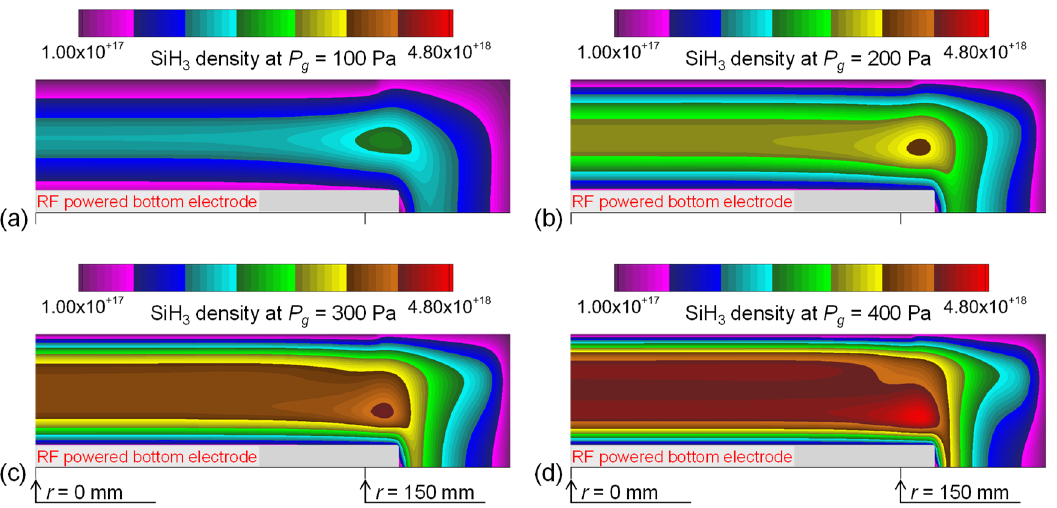
Figure 9. The spatial profiles of the time ‐ averaged SiH 3 density (m − 3 ) ( a ) for Case 9, ( b ) for Case 10, ( c ) for Case 11, and ( d ) for Case 12.